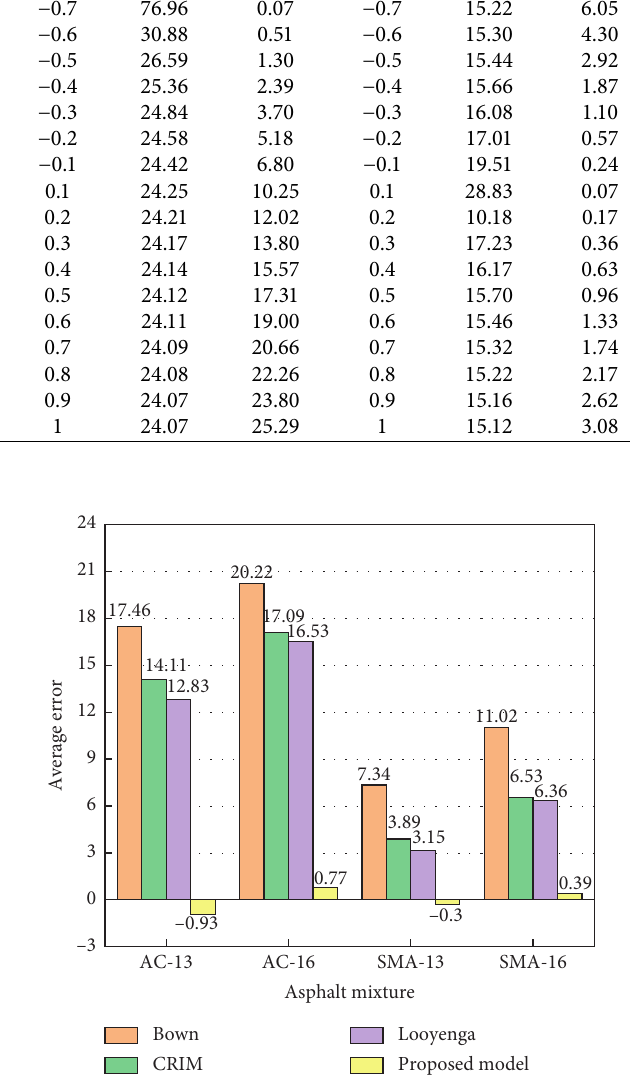
Figure 11: Average error of the classical model and the proposed